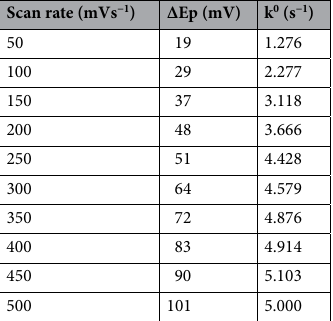
Table 1. Variation of the voltammetric parameters for PA at different scan